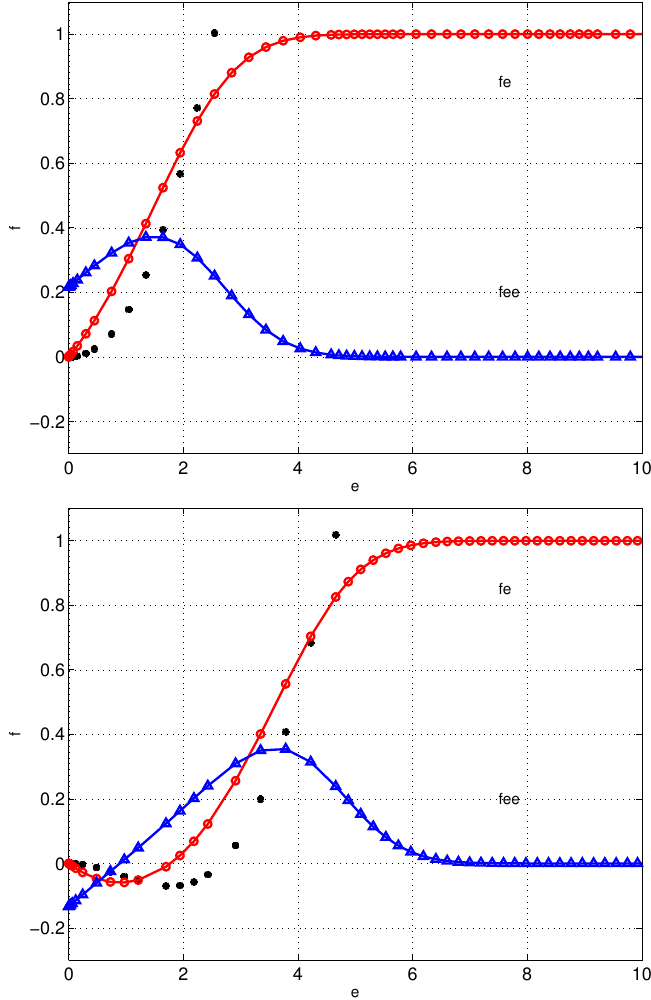
Figure 5. Normal and reverse flow solutions to Falkner–Skan model for β = − 1.5. The symbols • denote values of f ( η )